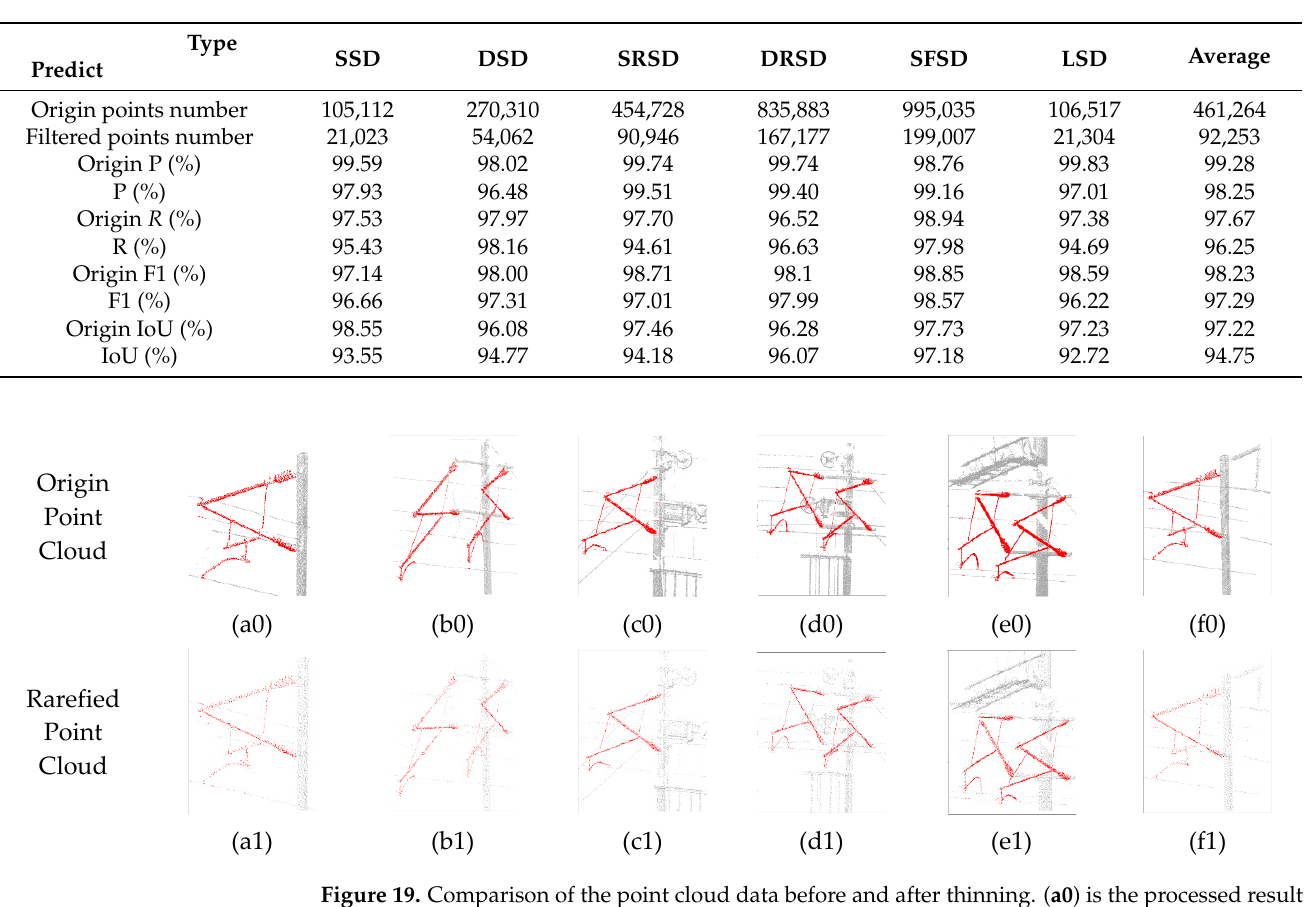
Figure 19. Comparison of the point cloud data before and after thinning. (a0) is the processed result of origin point cloud of SSD, (a1) is the processed result of rarefied point cloud of SSD, (b0) is the processed result of origin point cloud of DSD, (b1) is the processed result of rarefied point cloud of DSD, (c0) is the processed result of origin point cloud of SRSD, (c1) is the processed result of rarefied point cloud of SRSD, (d0) is the processed result of origin point cloud of DRSD, (d1) is the processed result of rarefied point cloud of DRSD, (e0) is the processed result of origin point cloud of SFSD, (e1) is the processed result of rarefied point cloud of SFSD, (f0) is the processed result of origin point cloud of LSD, (f1) is the processed result of rarefied point cloud of LSD.